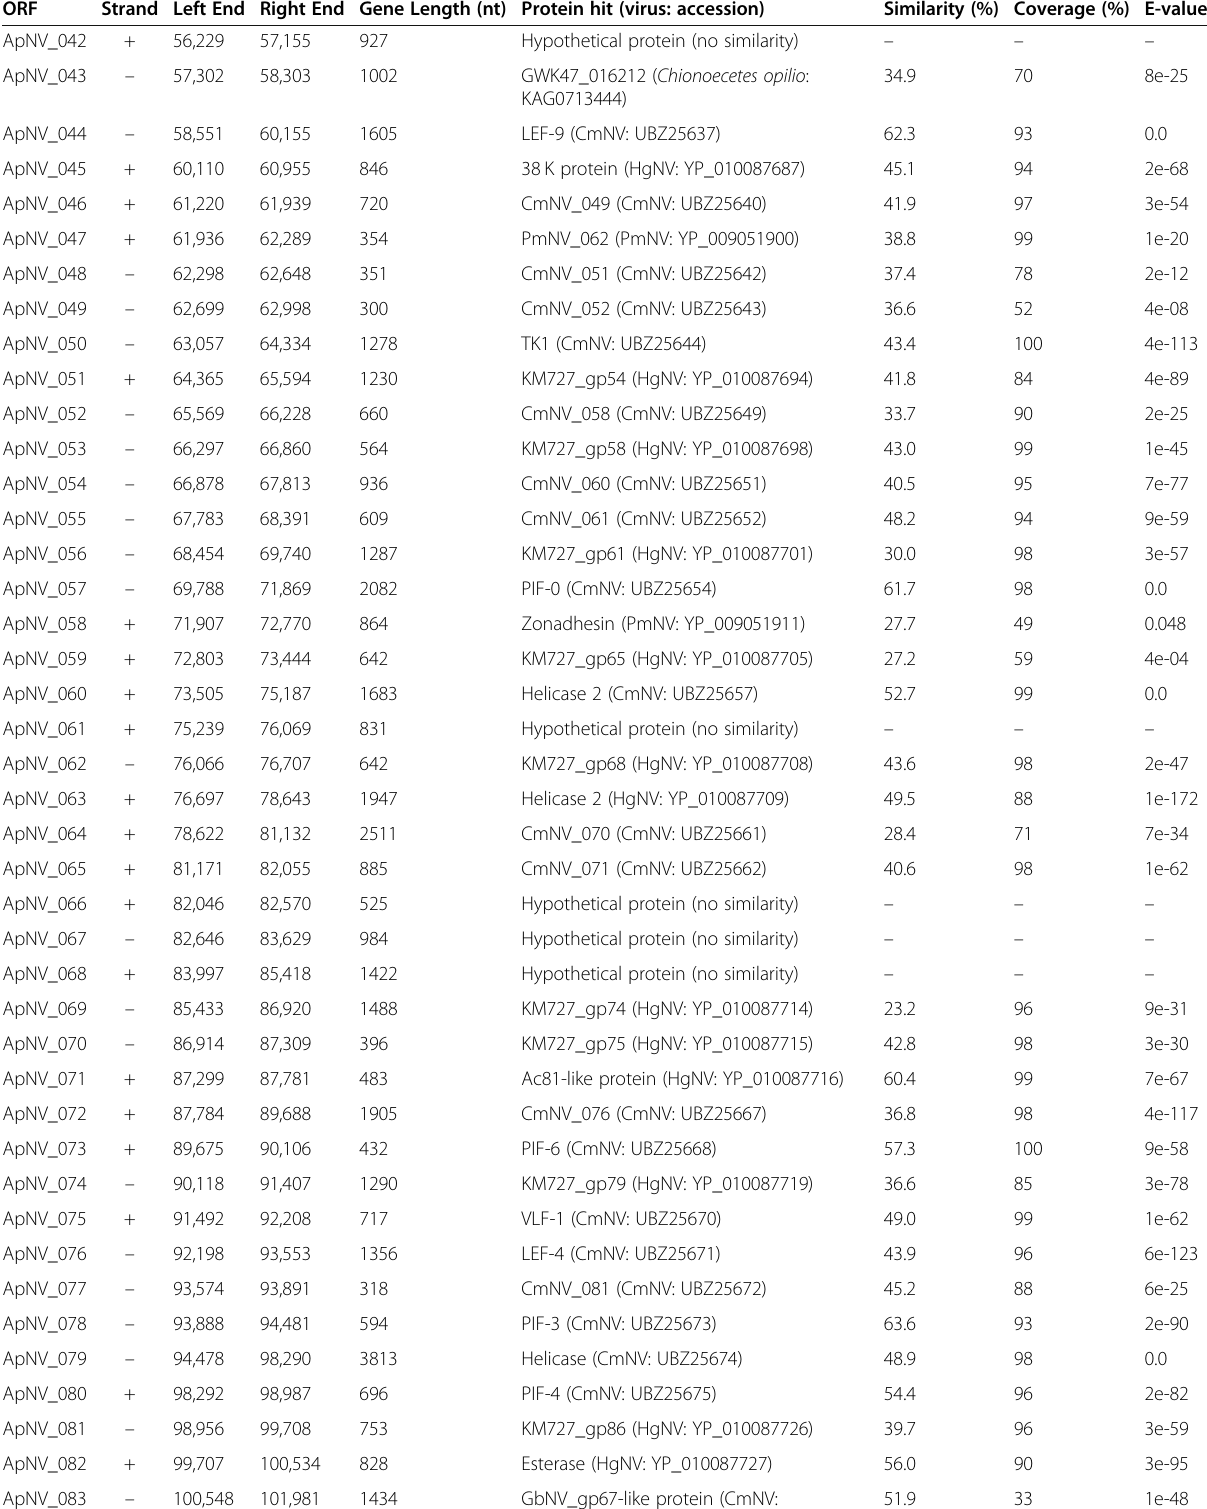
Table 2 ‘ Aratus pisonii nudivirus ’ (ApNV) protein similarity table. Similarity and function/domain are determined using